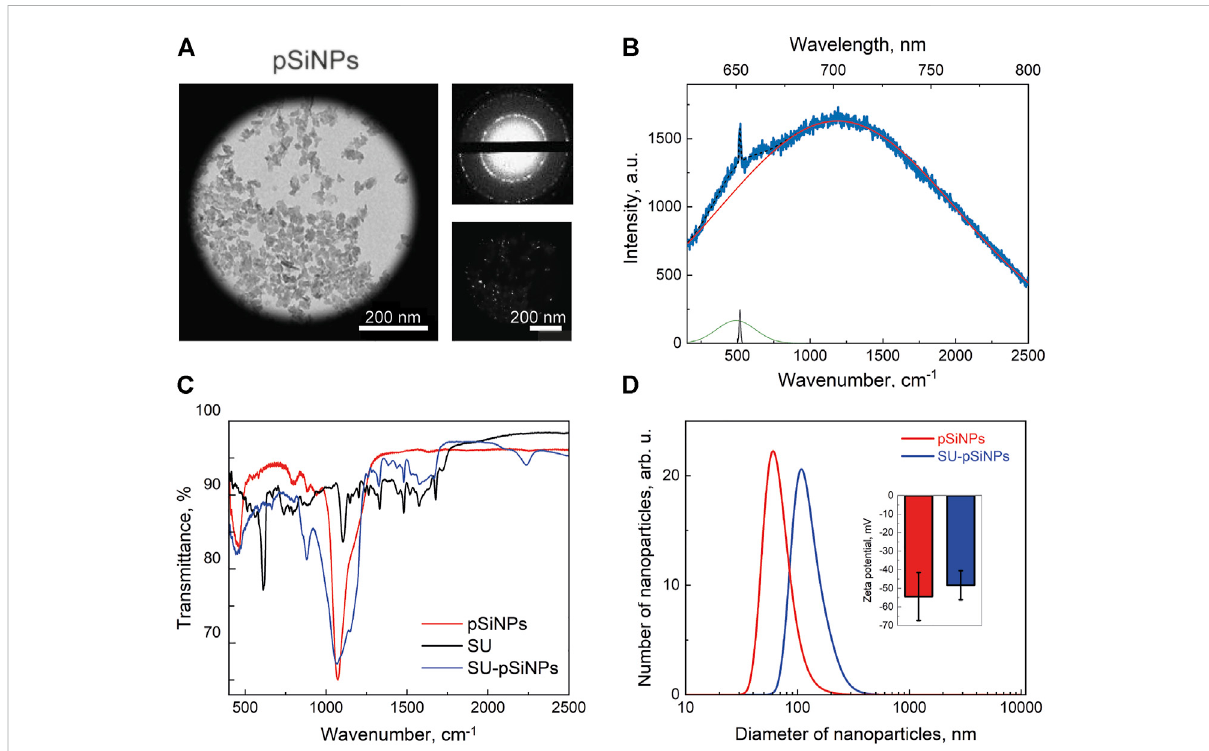
FIGURE 1 CharacterizationofpSiNPs. (A) TEMimageofpSiNPs(left)withanelectrondiffractionpattern(topsmallpicture)andadark- fi eldimage(bottom small picture). (B) PL and Raman spectra of pSiNPs. Experimental spectrum (blue line) and its deconvolution, i.e., resulted spectrum (dashed black line)andcomponents:PL(redline),RamanamorphousSi(480 cm − 1 — greenline),andnc-Si(518 cm − 1 — blackline)peaks.Laserexcitationwavelength is 633 nm. (C) FTIR spectrum of pSiNPs, SU, and SU-pSiNPs. (D) Diameter distribution of pSiNPs before (red) and after (blue) loading of SU in aqueous suspension measured by means of dynamic light scattering. The inset shows zeta potentials of